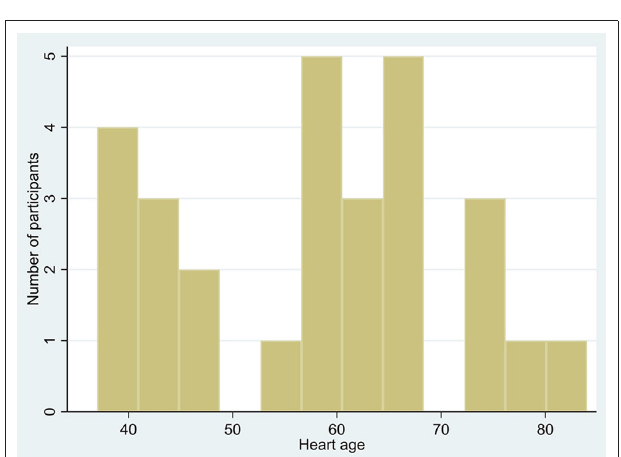
FIGURE 2 | Distribution of heart age.